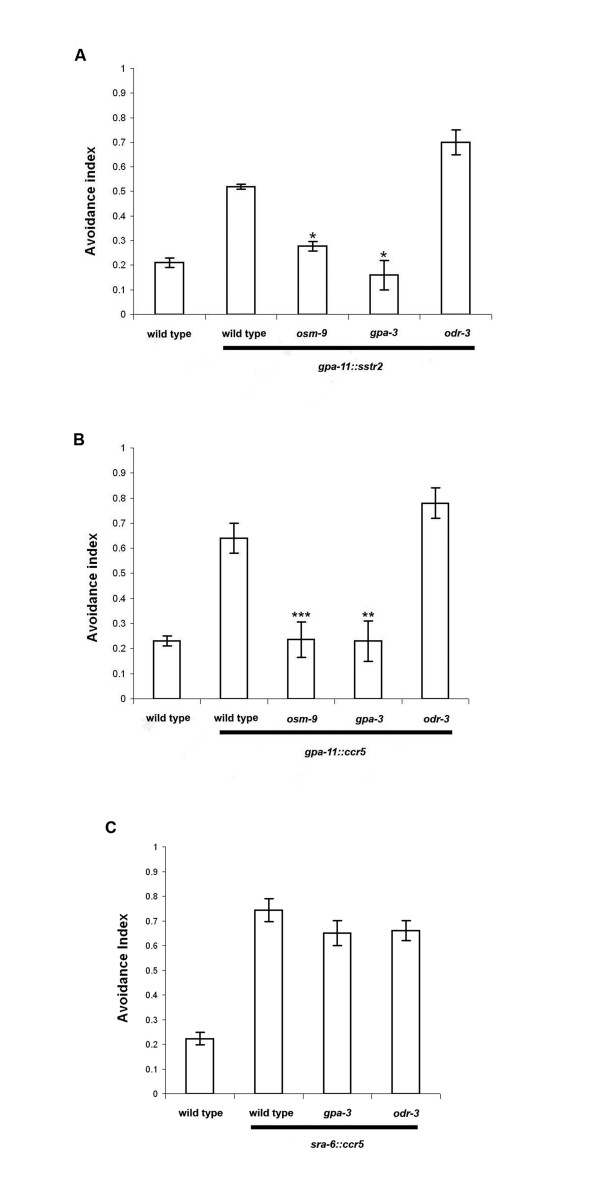
Heterologously expressed GPCRs are integrated into an endogenous signalling pathway in C. elegans. Mutation of the TRPV channel subunit osm-9 and the Gα subunit gpa-3 fully abolished avoidance of (A) 25 μM SST-28 in Sstr2 transgenic animals and (B) 25 μM MIP-1α in CCR5 transgenic animals. Mutation of Gα subunit odr-3 did not affect these responses. (C) In contrast, mutation of either gpa-3 or odr-3 did not have a significant effect on avoidance response in sra6::CCR5 transgenic animals. Each data point represents an average of at least 3 independent assays for wild type and each respective strain. Error bars denote the standard error of the mean. Asterisks indicate a statistically significant difference between osm-9 or gpa-3 mutant animals and wild type animals carrying the Sstr2 or CCR5 transgenes (*p ≤ 0.05, **p ≤ 0.01, ***p ≤ 0.005).